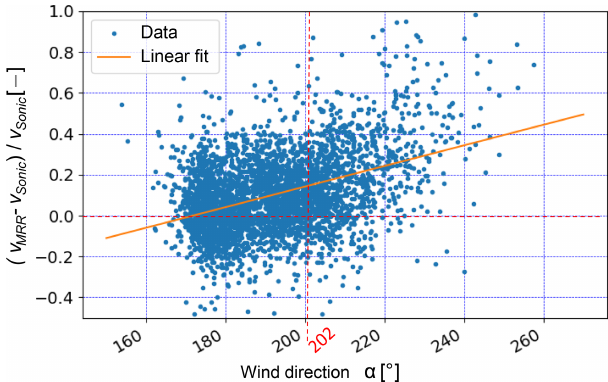
Figure 6. Relative difference between MRR and Sonic wind veloc- ity in the direction 202 ◦ as a function of wind direction for EP1–